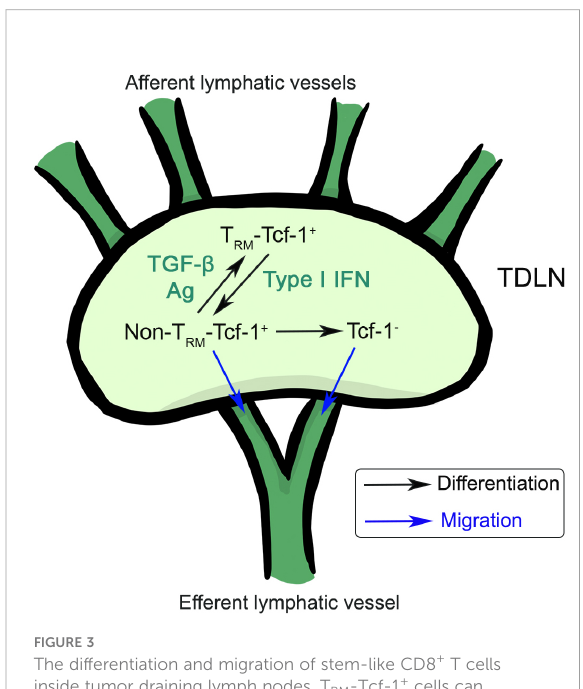
FIGURE 3 The differentiation and migration of stem-like CD8 + T cells inside tumor draining lymph nodes. T RM -Tcf-1 + cells can differentiate into non-T RM -Tcf-1 + cells, which can further differentiate into Tcf-1 - effector T cells. Non-T RM -Tcf-1 + and Tcf-1 - T cells have the capacity to migrate to distal organs. TGF- b , antigen and type I IFN control the differentiation of Tcf-1 + T cells inside tumor draining